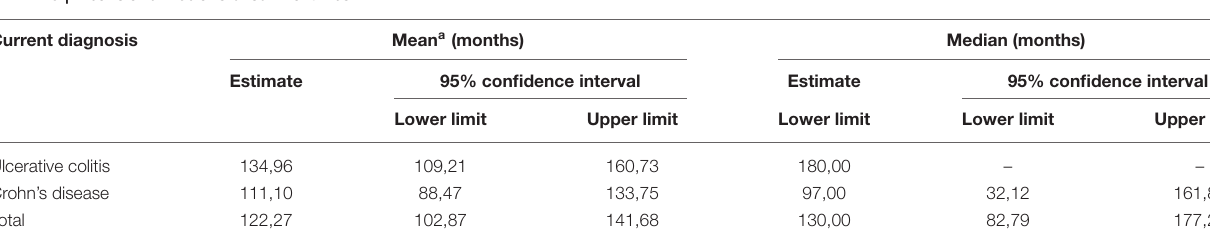
TABLE 6 | Means and medians of survival